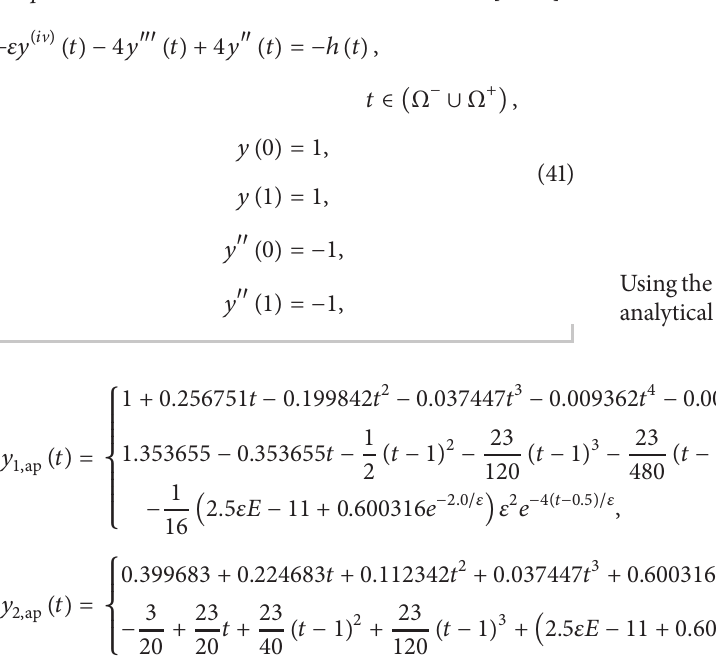
Example 3. Consider the fourth-order SPBVP from [13,